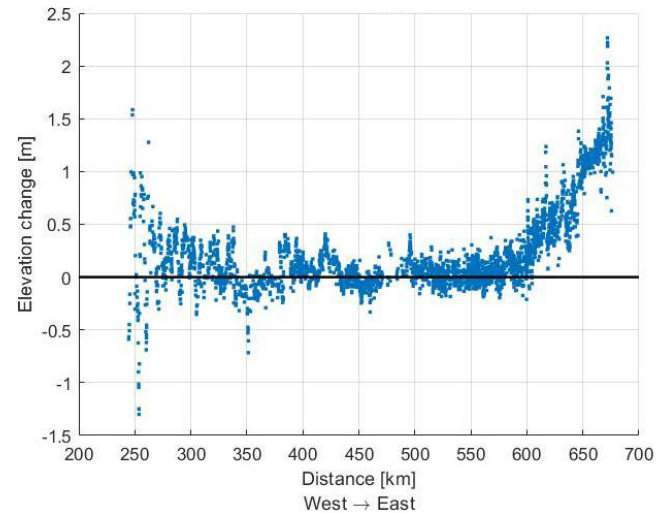
Figure 9. Comparison of the minimum distances method with 5 m tolerance ( top ) and the crossing point method ( bottom ).